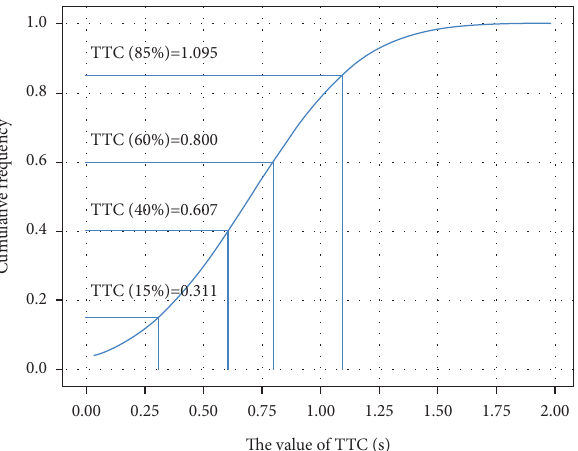
Figure 3: Cumulative frequency curve for the TTC.